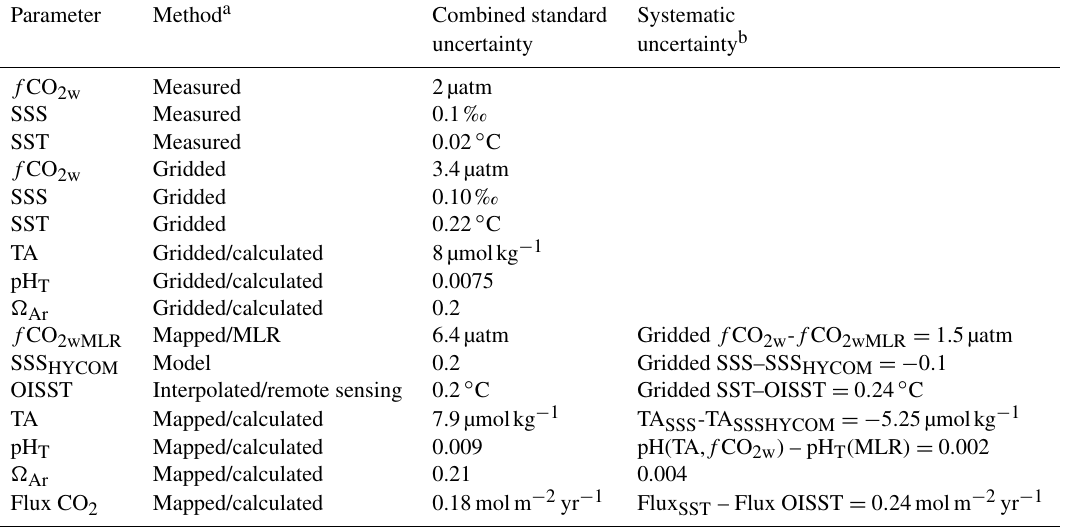
Table 2. Estimated uncertainties in measured, gridded and mapped variables. Parameter Method a Combined standard Systematic uncertainty uncertainty